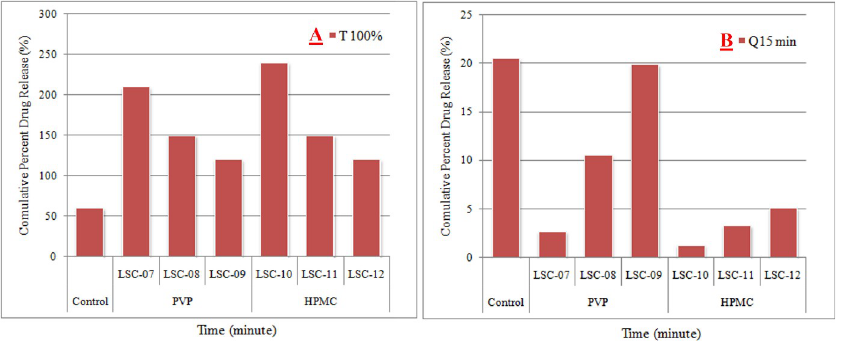
Fig 9. Comparison of time taken for maximal drug release (T100%) and amount of drug release during initial 15 min (Q15min) from liquisolid compacts containing different concentrations of PVP and HPMC, with control formulation (tablets prepared by direct compression